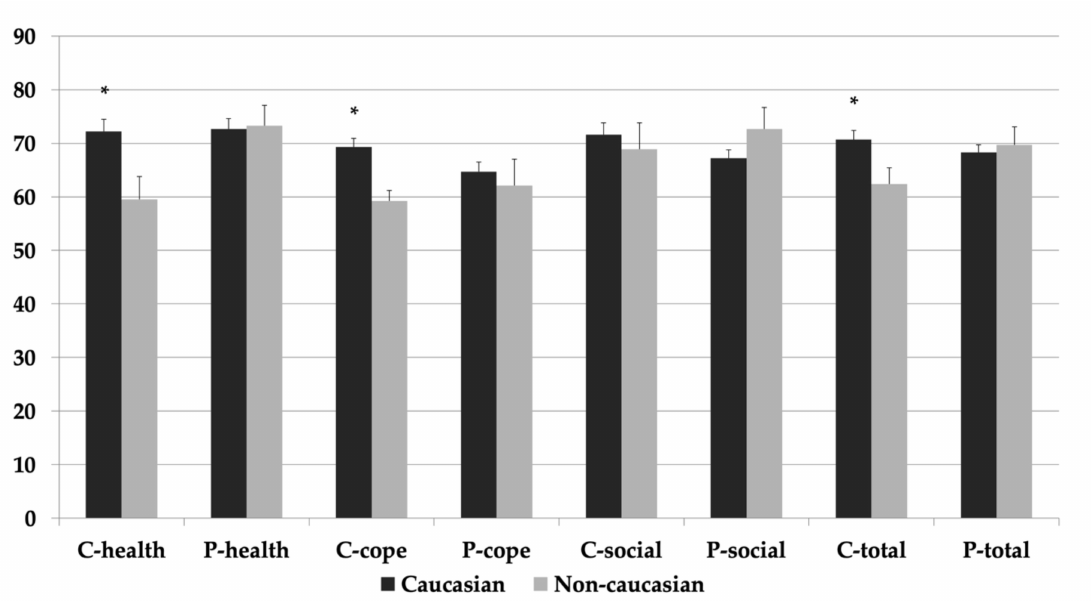
Figure 3. Total and sub-domain scores (Future Health [health], Coping and Adjustment [cope] and Social-Emotional [social]) for both child (C) and parental (P) HRQOL reports for children of Caucasian and non-Caucasian ancestry. All values expressed as mean ± standard error. * Significant at p <